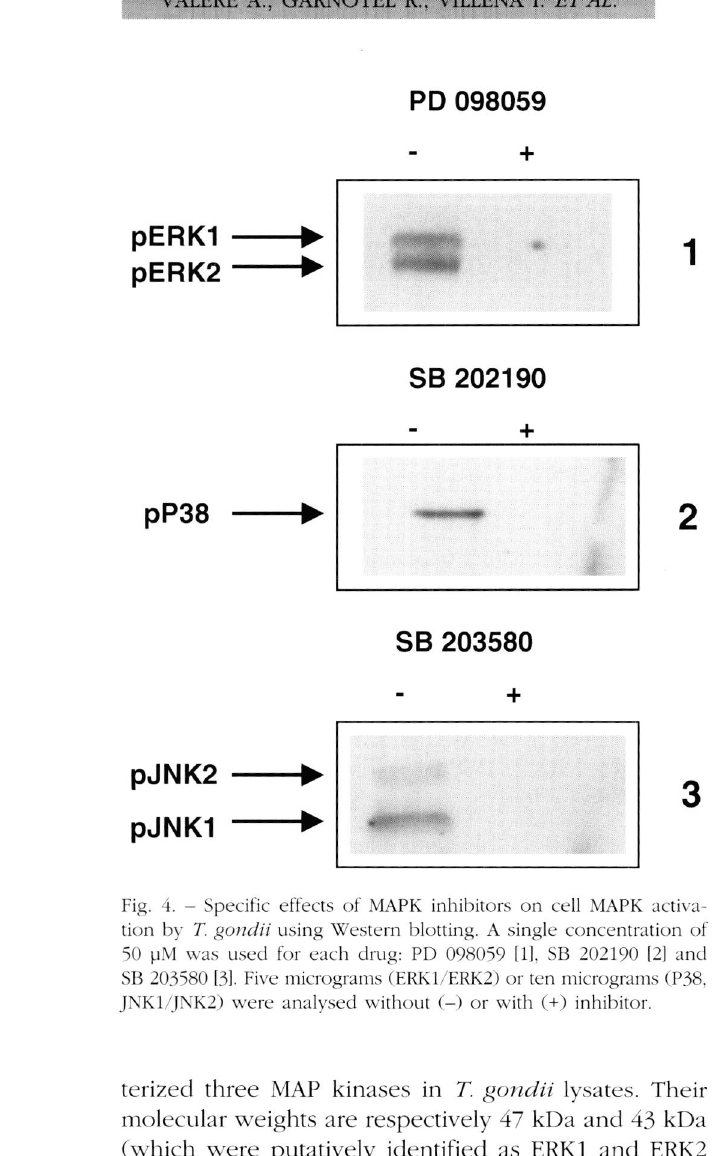
Fig. 4. - Specific effects of MAPK inhibitors on cell MAPK activa­ tion by T. gondii using Western blotting. A single concentration of 50 uM was used for each drug: PD 098059 [1]. SB 202190 [2] and SB 203580 [3]. Five micrograms (ERK1/ERK2) or ten micrograms (P38, JNK1/JNK2) were analysed without (-) or with (+)